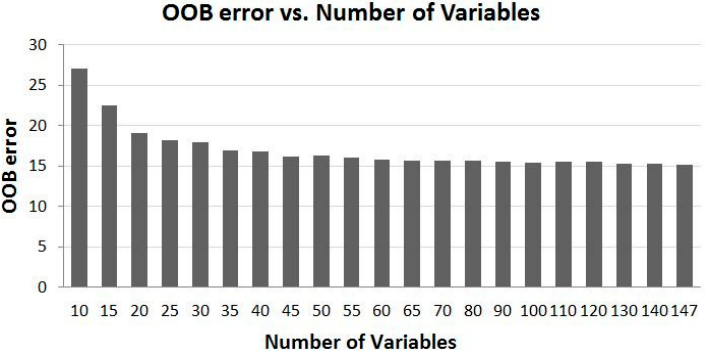
Figure 4. The relationship of Out of Bag (OOB) error and the number of the most important variables. OOB error decreases with the increase of the number of variables.